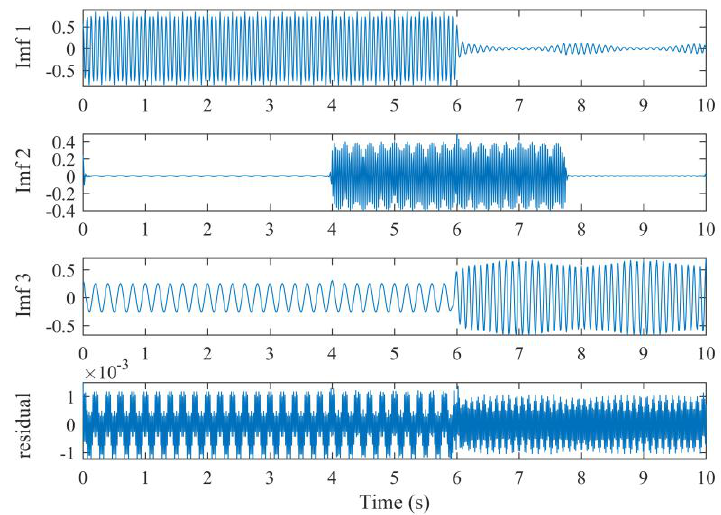
Figure 5. The VMD decomposition results and the residual. IMF1 and IMF2 refer to Figure 2c,e, respectively, and IMF3 refers to both Figure 2b,d.